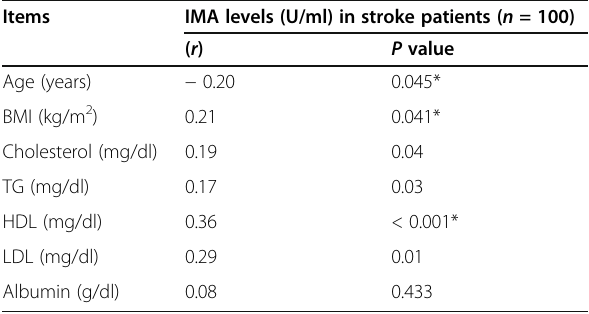
Table 7 Correlations between IMA levels with clinical characteristics and laboratory data at stroke onset in stroke patients